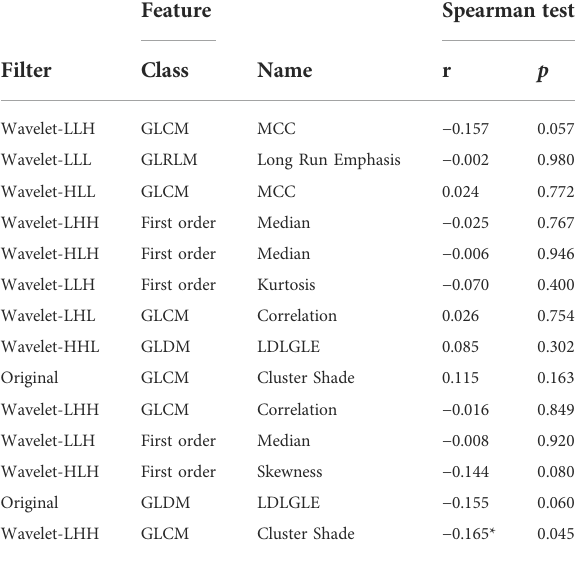
TABLE4CorrelationofPETtextureparametersselectedtopredictthe COX-2 expression level with same texture parameters of IHC